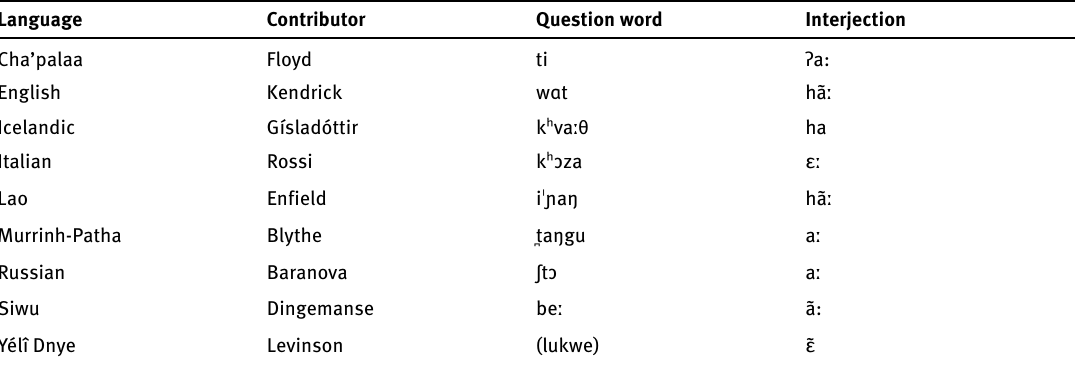
Table 7: Question words (“what?”) and interjections (“huh?”) used as open request type repair initiators in nine spoken